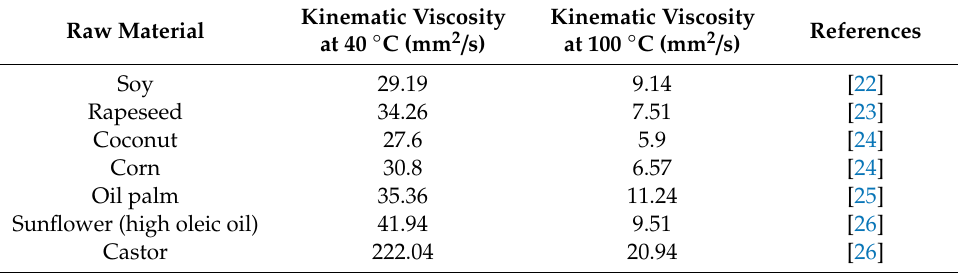
Table 1. Kinematic viscosity of selected plant oils.